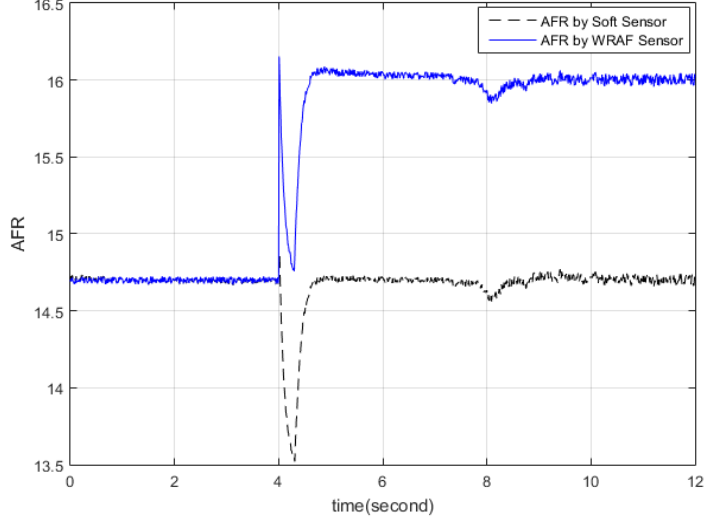
Figure 13. AFR by WRAF sensor and AFR by soft sensor.